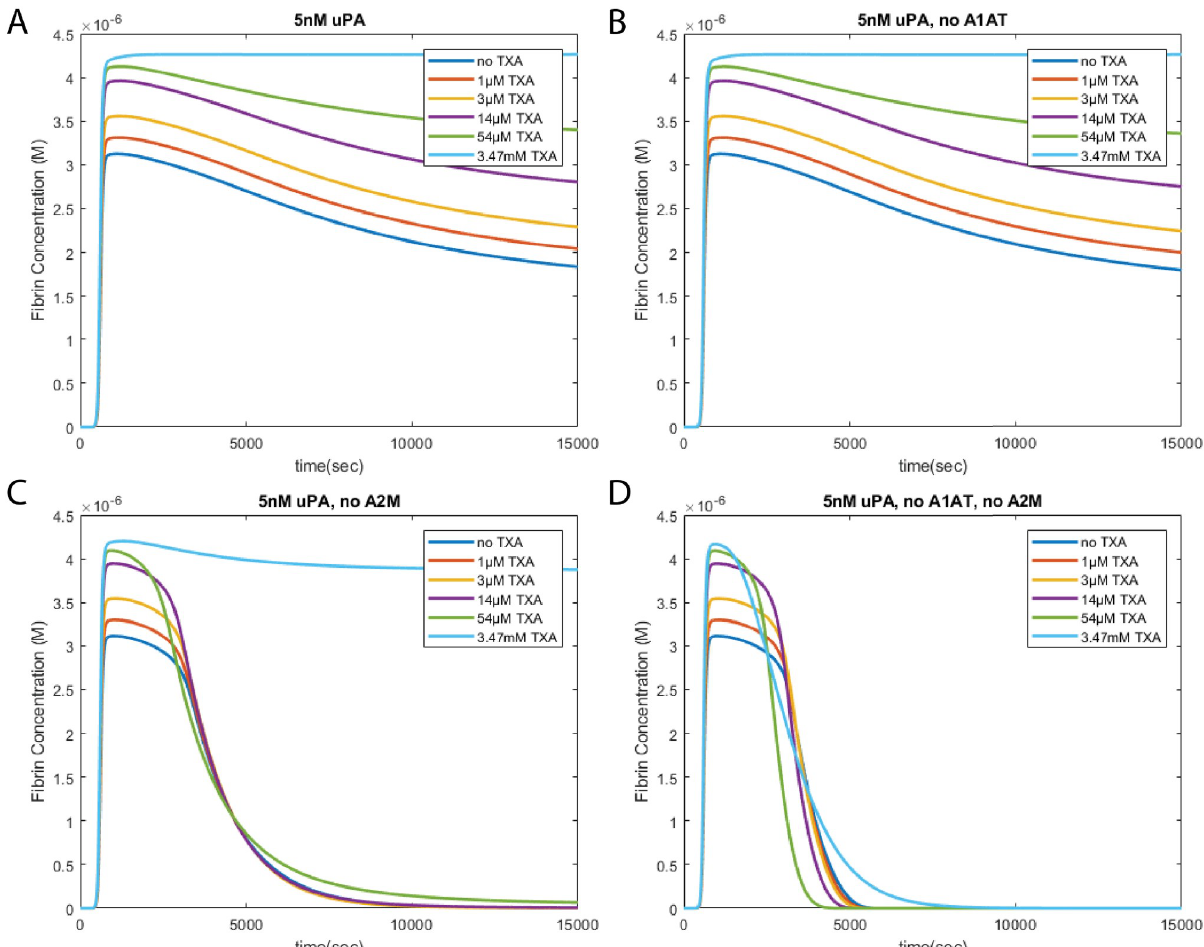
Fig 5. Effects of TXA on uPA mediated fibrinolysis. Modeling results reveal that the effect of TXA on uPA mediated fibrinolysis greatly depends on the presence or absence of plasmin inhibitors in the system. When A2M is in the system, with (A) or without (B) A1AT, fibrinolysis is inhibited and TXA behaves in an anti-fibrinolytic fashion. When A2M is removed from the system, but A1AT is still present (C), fibrinolysis can be observed. Under these circumstances, TXA exhibits anti-fibrinolytic behavior and acts to slow down fibrinolysis in a dose dependent manner. When both A2M and A1AT are removed from the system (D), TXA becomes pro-fibrinolytic, and speeds up the rate of fibrinolysis through increased plasmin generation and antiplasmin depletion. These simulations are initiated with 5 pM tissue factor, and an initial uPA concentration of 5